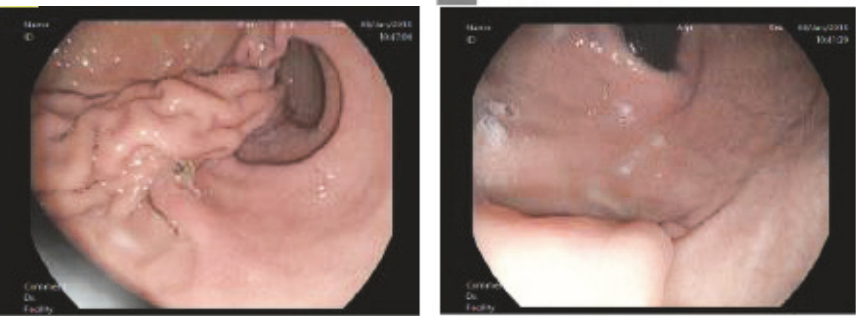
Figure 3: Endoscopy of female patient who regained weight 1 year after plication.